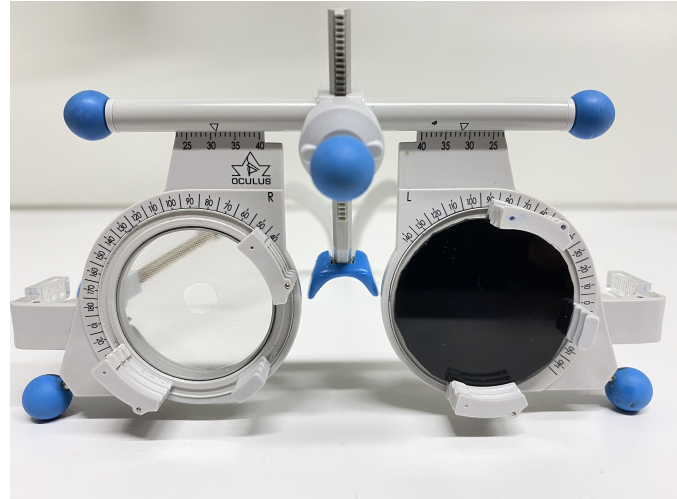
Figure 1. Trial frame example with the 0.4 Bangerter foil pasted on a plane lens, while the clear central aperture is centered to the lens, inserted at the back side of the trial frame—in front of the right eye. The slots on the front side were reserved for the individual sphero-cylindrical correction and the near compensation lens. The infrared filter on the left eye was used to measure the pupil size.